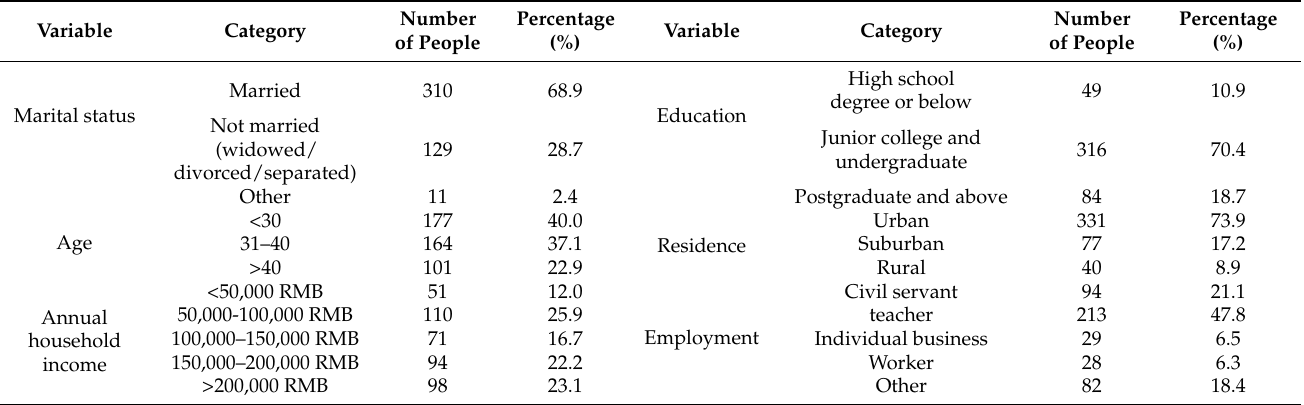
Table 1. Sample’s sociodemographic profile (%), N =